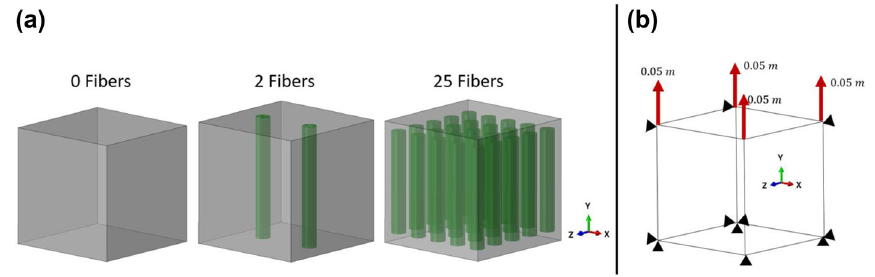
Fig. 6 a Unit cube models used containing 0, 2, and 25 embedded elements. b Applied displacement boundary conditions for the embedded element